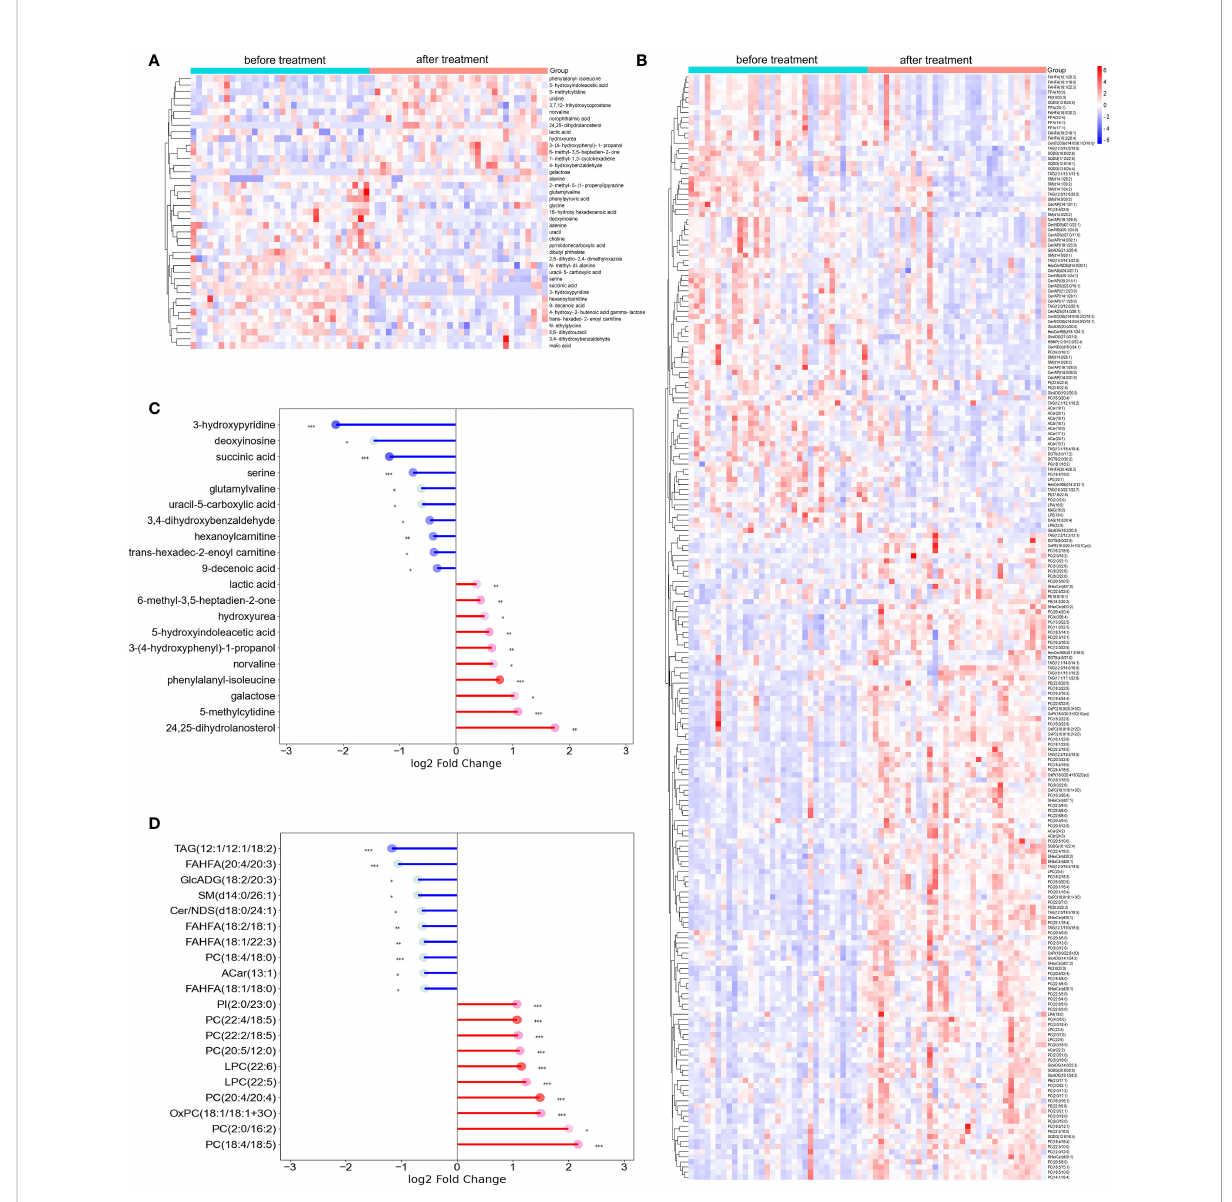
FIGURE 2 The representative differential metabolites identi fi ed from metabolomics and lipidomics analysis. (A, B) Hierarchical clustering analysis of metabolome and lipid pro fi les. Red means levels of metabolites increased after dupilumab therapy, while blue is decreasing. (C, D) The matchstick diagram showed the top 20 signi fi cantly change metabolites in metabolomics and lipidomics analysis based on fold change. The color depth of the dot represents the VIP value. Acar, Acylcarnitine; Cer/ADS, Ceramide alpha-hydroxy fatty acid-dihydrosphingosine; Cer/AP, Ceramide alpha-hydroxy fatty acid-phytospingosine; Cer/AS, Ceramide alpha-hydroxy fatty acid-sphingosine; Cer/EODS, Ceramide Esteri fi ed omega-hydroxy fatty acid-dihydrosphingosine; Cer/NDS, Ceramide non-hydroxyfatty acid-dihydrosphingosine; Cer/NS, Ceramide non- hydroxyfatty acid-sphingosine; DAG, Diacylglycerol; DGTS, Diacylglyceryl trimethylhomoserine; FFA, Free fatty acid; FAHFA, Fatty acid ester of hydroxyl fatty acid; GlcADG, glucuronosyldiacylglycerol; HBMP, Hemibismonoacylglycerophosphate; HexCer/NDS, Hexosylceramide non- hydroxyfatty acid-dihydrosphingosine; HexCer/NS, Hexosylceramide non-hydroxyfatty acid-sphingosine; LPA, Lysophosphatidic acid; LPC, Lysophophatidylcholine; LPE, Lysophosphatidylethanolamine; MAG, Monoacylglycerol; OxPC, Oxidized phosphatidylcholine; OxPE, Oxidized phosphatidylethanolamine; OxPI, Oxidized phosphatidylglycerol; PC, Phosphatidylcholine; PE, Phosphatidylethanolamine; PG, Phosphatidylglycerol; PI, Phosphatidylinositol; SHexCer, SulfurHexosylceramide hydroxyfatty acid; SM, Sphingomyelin; SQDG, Sulfoquinovosyl diacylglycerol; TAG, triacylglycerol. * represents P<0.05, ** represents P<0.01, *** represents